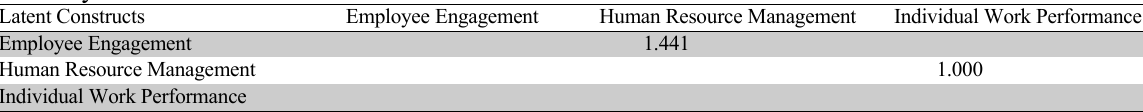
Summary of outer VIF value across constructs